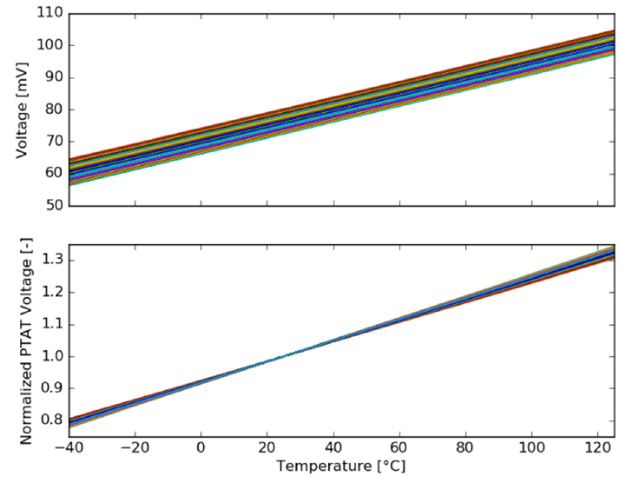
Figure 13. Monte Carlo simulations of PTAT output voltage.